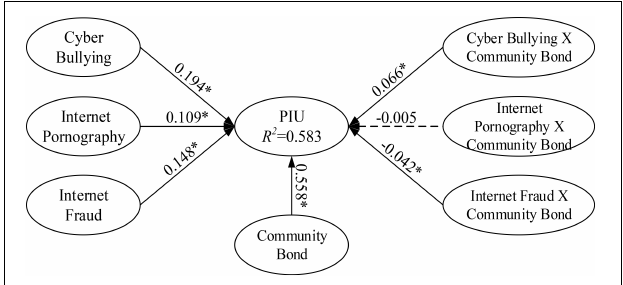
FIGURE 4 | Path coefficients for the research model (including interaction effect).